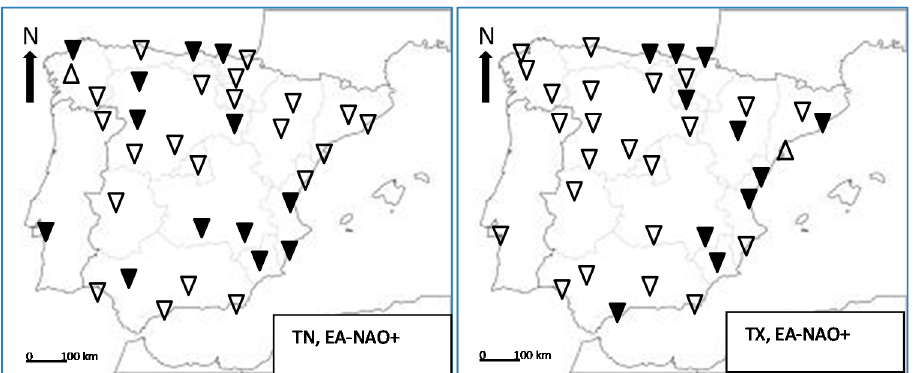
Figure 7. Difference of TN and TX mean values for EA-NAO+ composite and the mean of the complete period 1950–2019 for autumn. Triangle up (down) means positive (negative) difference, full (empty) triangle means significant (not significant) difference at the 95% confidence level.